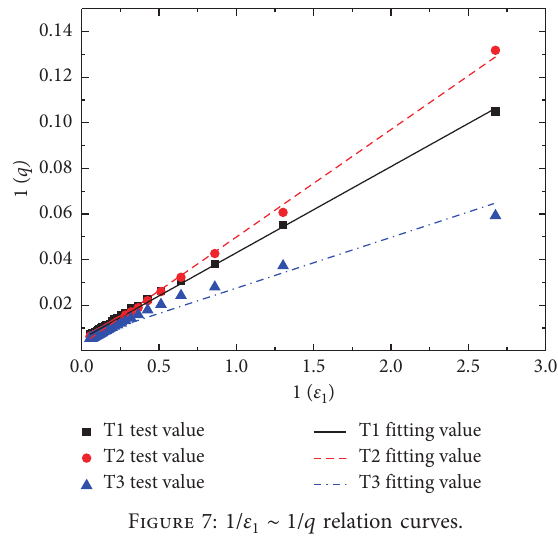
∼ 1/ q relation curves. 1